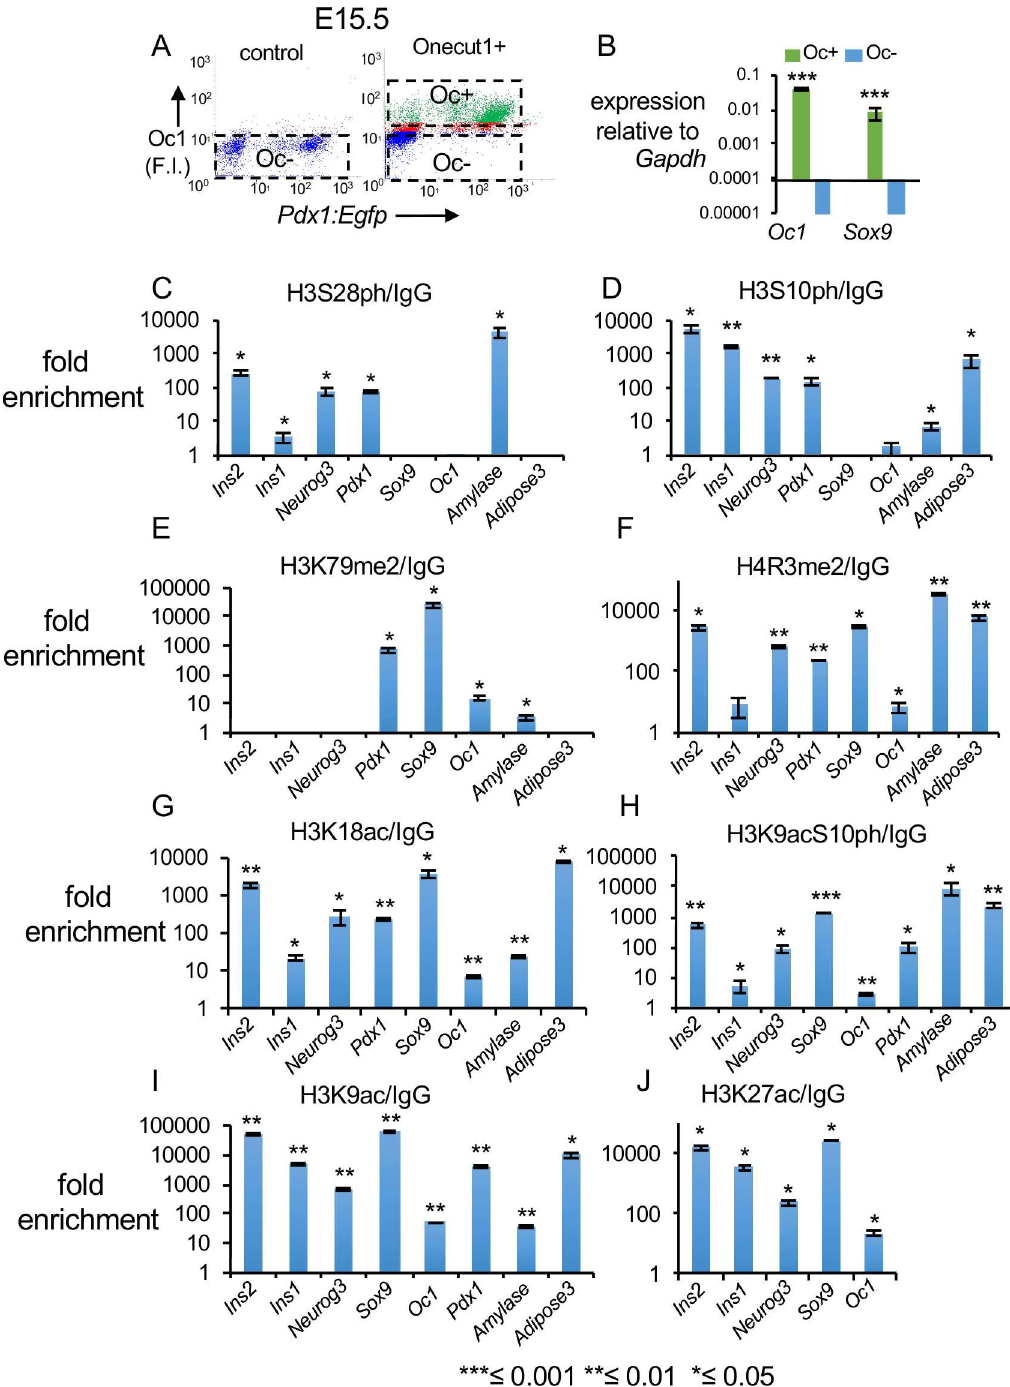
Fig 1. A screen for histone modifications down streamof signaling pathways in E15.5 pancreatic epithelial cells. (A) FACS scatter plots of cells treated with either IgG (control) or Onecut1 (Oc1+) antibodyfrom Pdx1 : Egfp E15.5 pancreata.The FACS purifiedOc1+ cells, both Pdx1-GFP+ (Oc1+P+) and Pdx1-GFP- (Oc1+P-), were used for ChIP and qPCR (box labeledOc+). The x and y axes indicatefluorescence intensity (F.I.). (B) RT-qPCR for ductal transcripts Oc1 and Sox9 in Oc+ (green)and Oc- (blue) cells. (C-J) Patterns for indicatedhistone modifications at select pancreatic genes(n = 3 technicalreplicates). Ins2 ( Insulin2 ), Ins1 ( Insulin1 ), Neurog3 ( Neurogenin3 ) and Amyl ( Amylase2a ). The y-axis shows enrichment over IgG. All P-valueswere calculatedby Student’s t-test, one tailed.